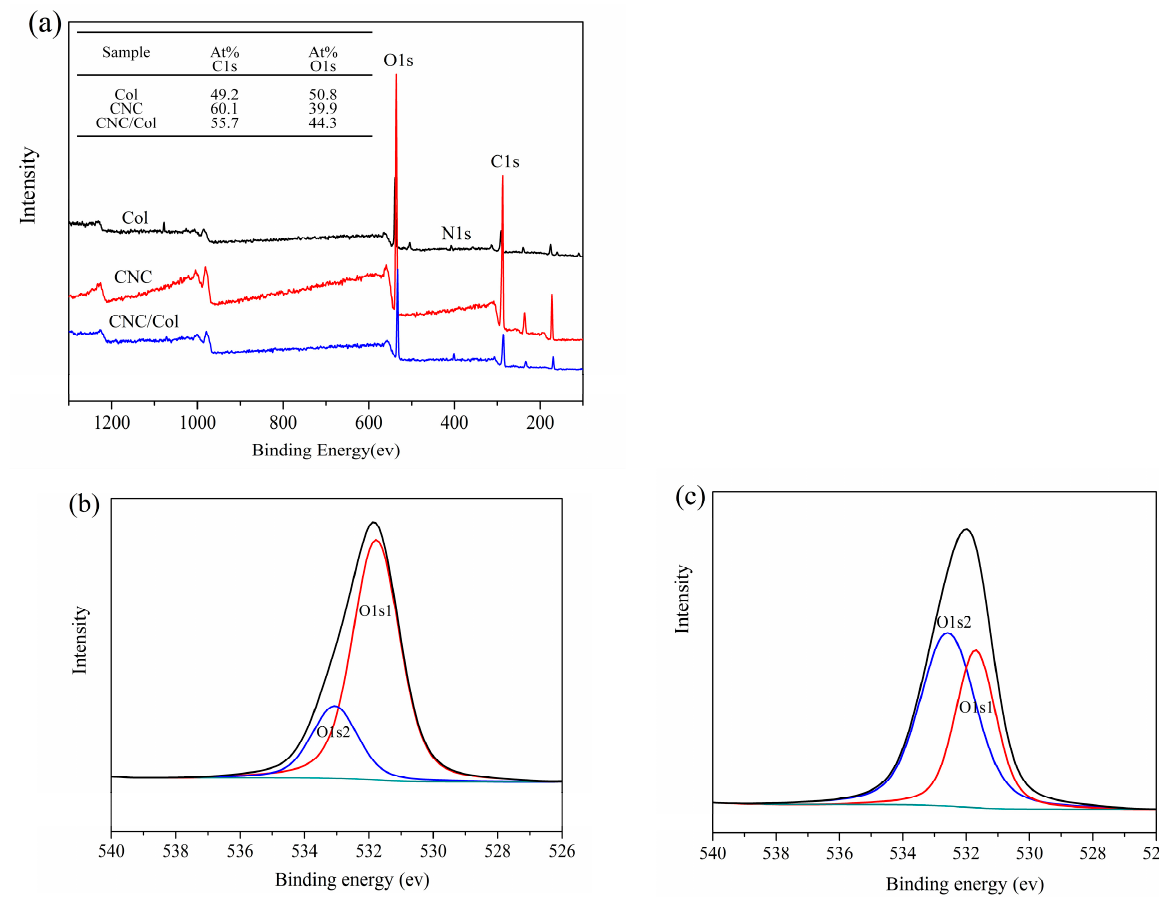
Figure 4. XPS wide scan spectra of the samples ( a ) and high-resolution XPS spectra of O1s for Col ( b ) and CNC/Col hydrogel ( c